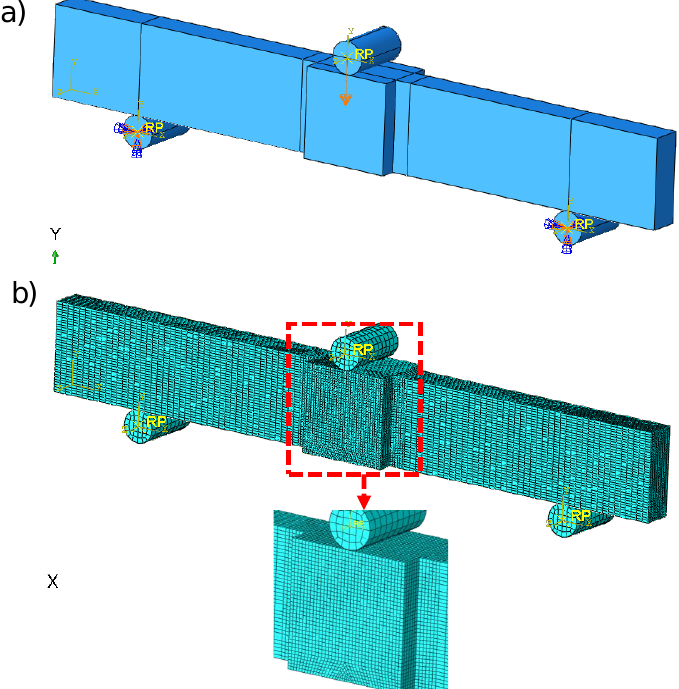
Figure 14. ( a ) FEA model setup and ( b ) mesh used.